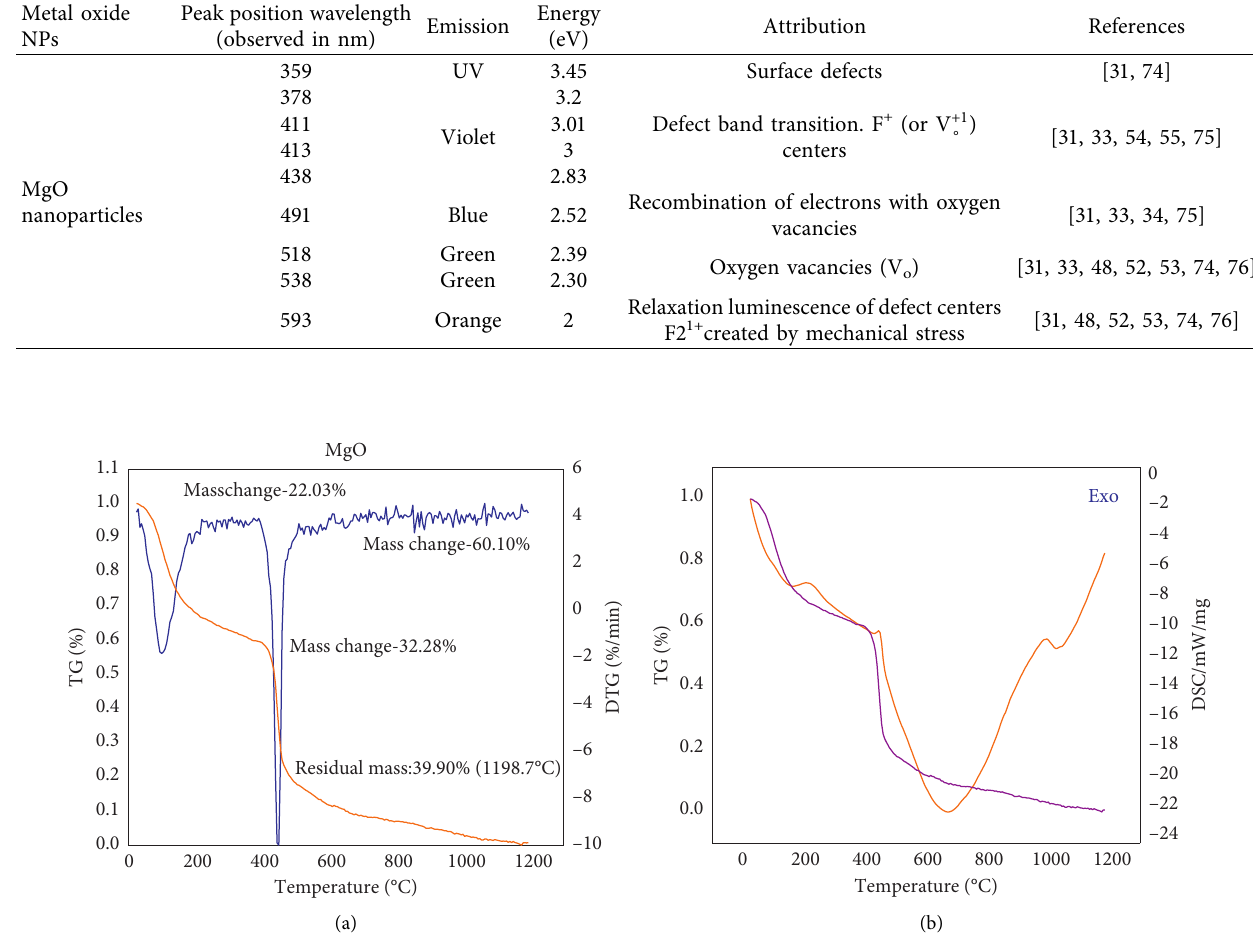
Figure 13: TGA DTA of MgO nanoparticles and TG-DSC of MgO nanoparticles (a,